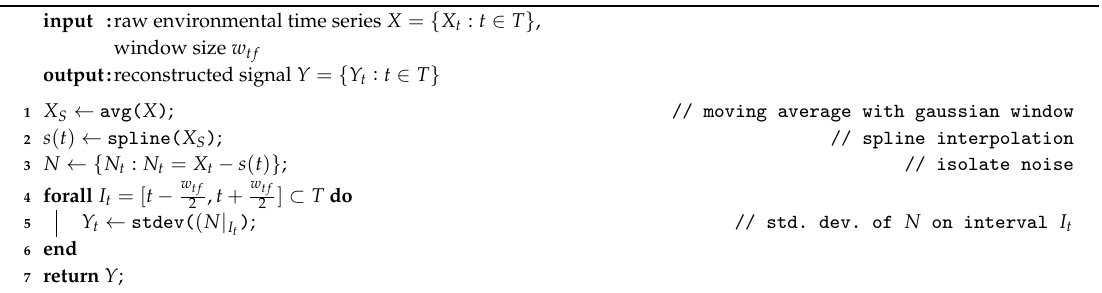
Algorithm 2: Poisson Particle Detection Algorithm (PPD) : Signal reconstruction from Poisson Noise